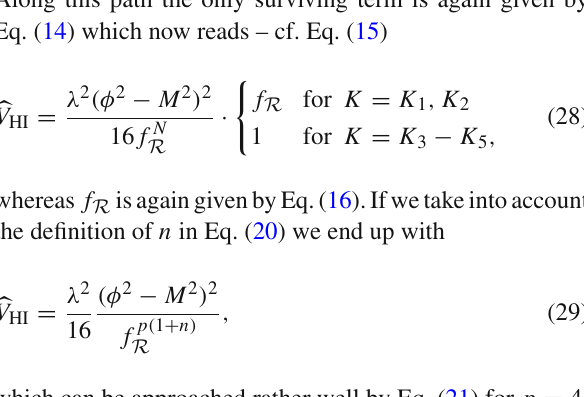
Table 2 Mass-squared spectrum of the model defined by Eqs. (24) and (25) for K = K 1 − K 5 along the path in Eq. (27) Fields Eigenstates